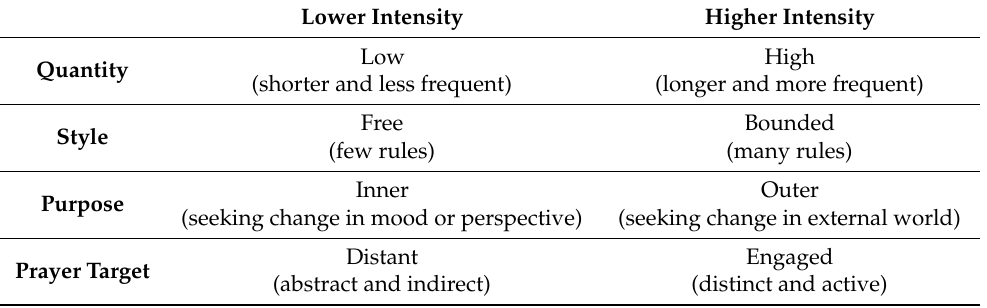
Table 1. Variations in the Prayer